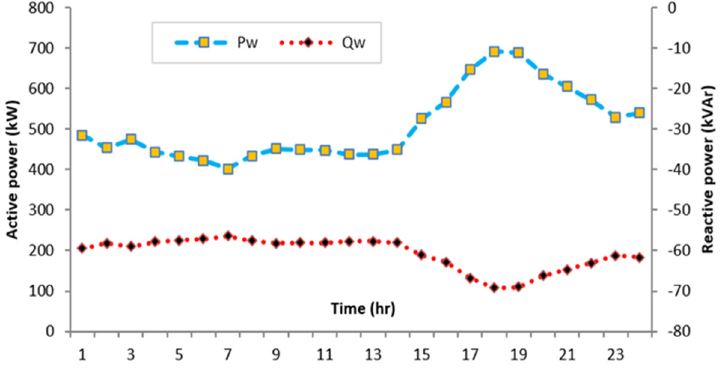
Figure 8. Scheduled active and reactive power from wind at each hour for the first MG system.